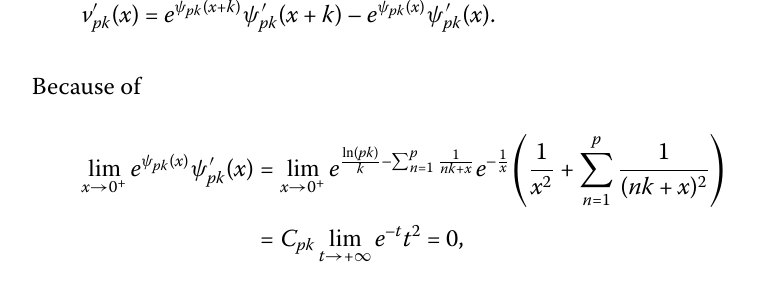
Table 1 Values of p , k , x 1 , x 2 , v pk ( x 1 ), v pk ( x 2